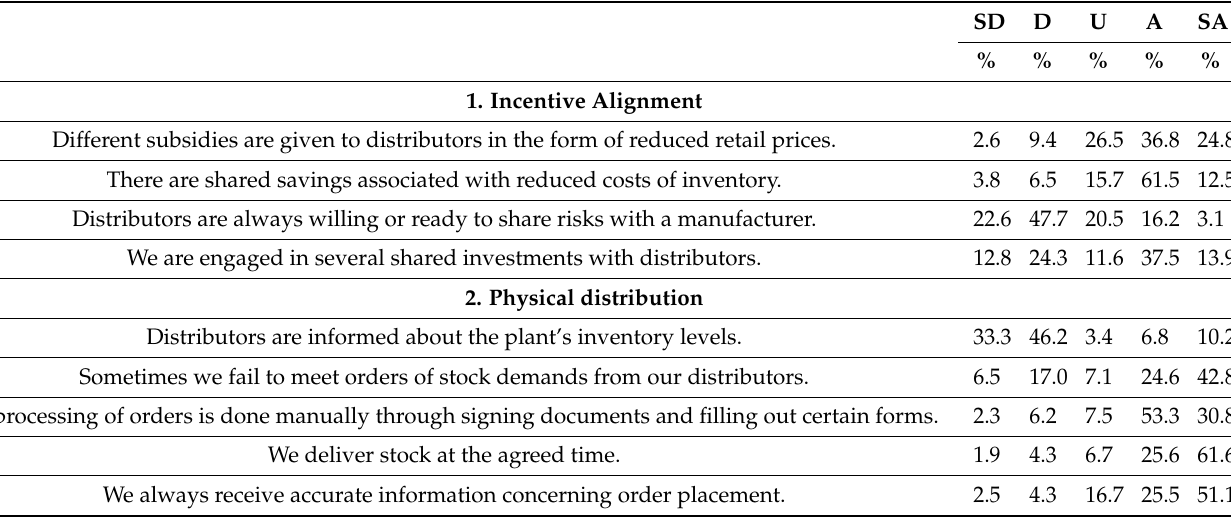
Table 2. Incentive alignment and physical